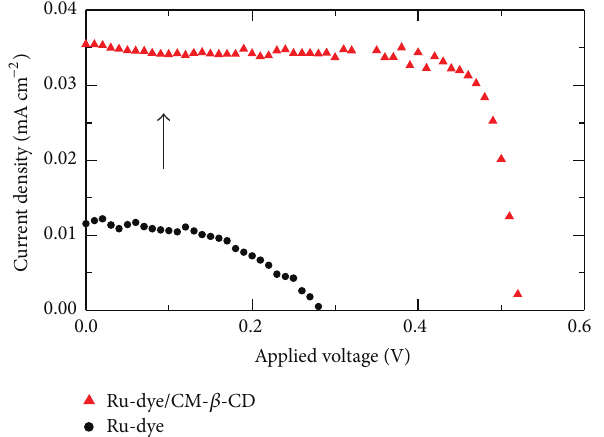
Figure 6: I-V profiles of the Ru-dye-containing and Ru-dye/CM- 𝛽 - CD-containing devices measured under 450 nm light irradiation.